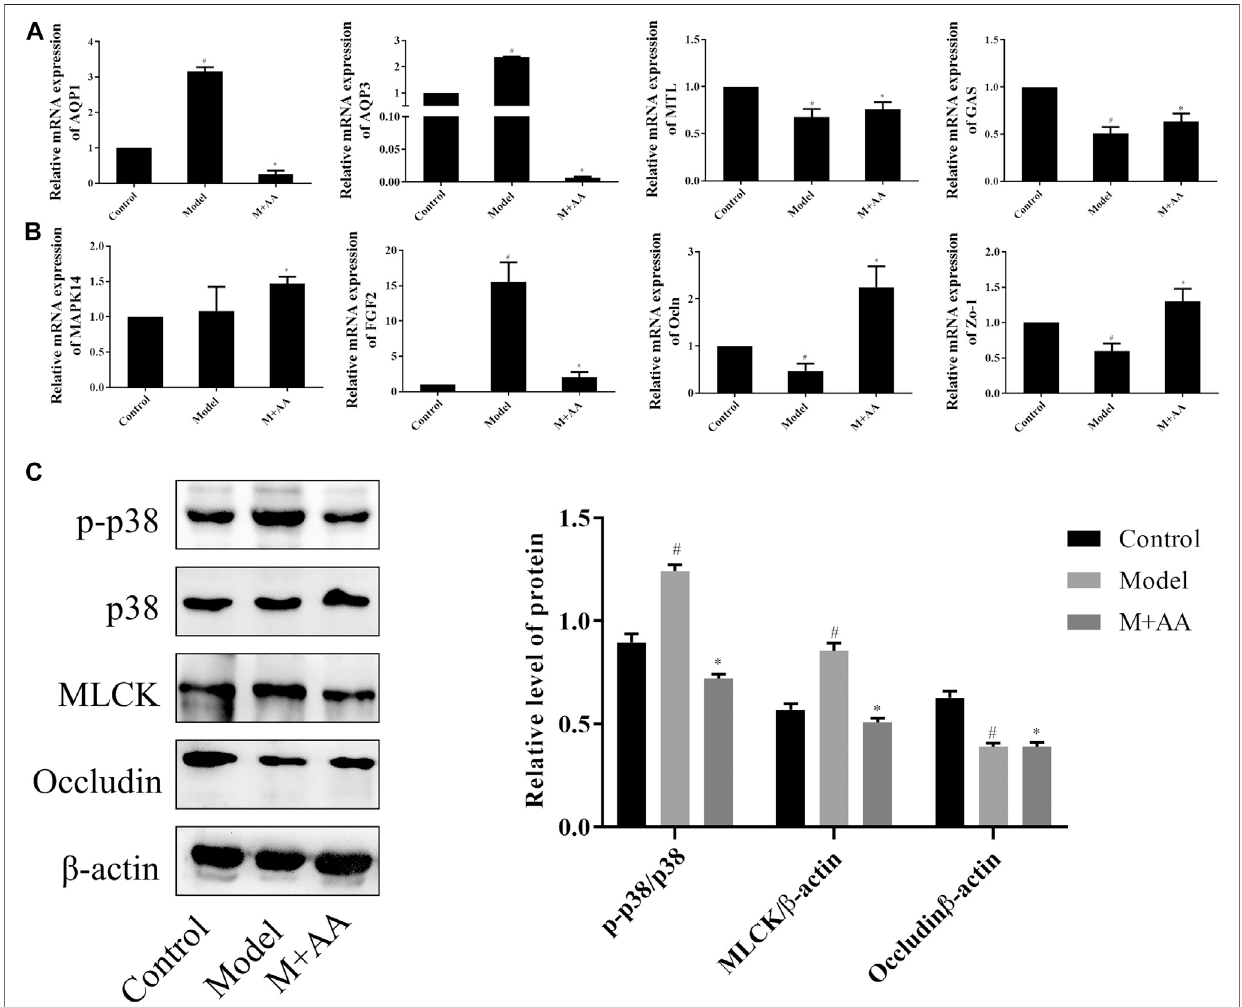
FIGURE8| EffectsofAAonsignalingmoleculesthatregulateintestinalmucosalbarrierfunctioninSDSrats( n (cid:2) 10).SDSratsweretreatedwith5 mg/kgofAA. (A) and (B) Relative mRNA expression of intestinal metabolism-related genes determined by qRT-PCR. β -actin was used as the internal reference. (C) Protein expression levels determined by Westernblot. Data represented mean ± SD. Resultsare expressed as the mean ± SD from at least three independentexperiments. * p < 0.05, compared with model; # p < 0.05 compared with control.